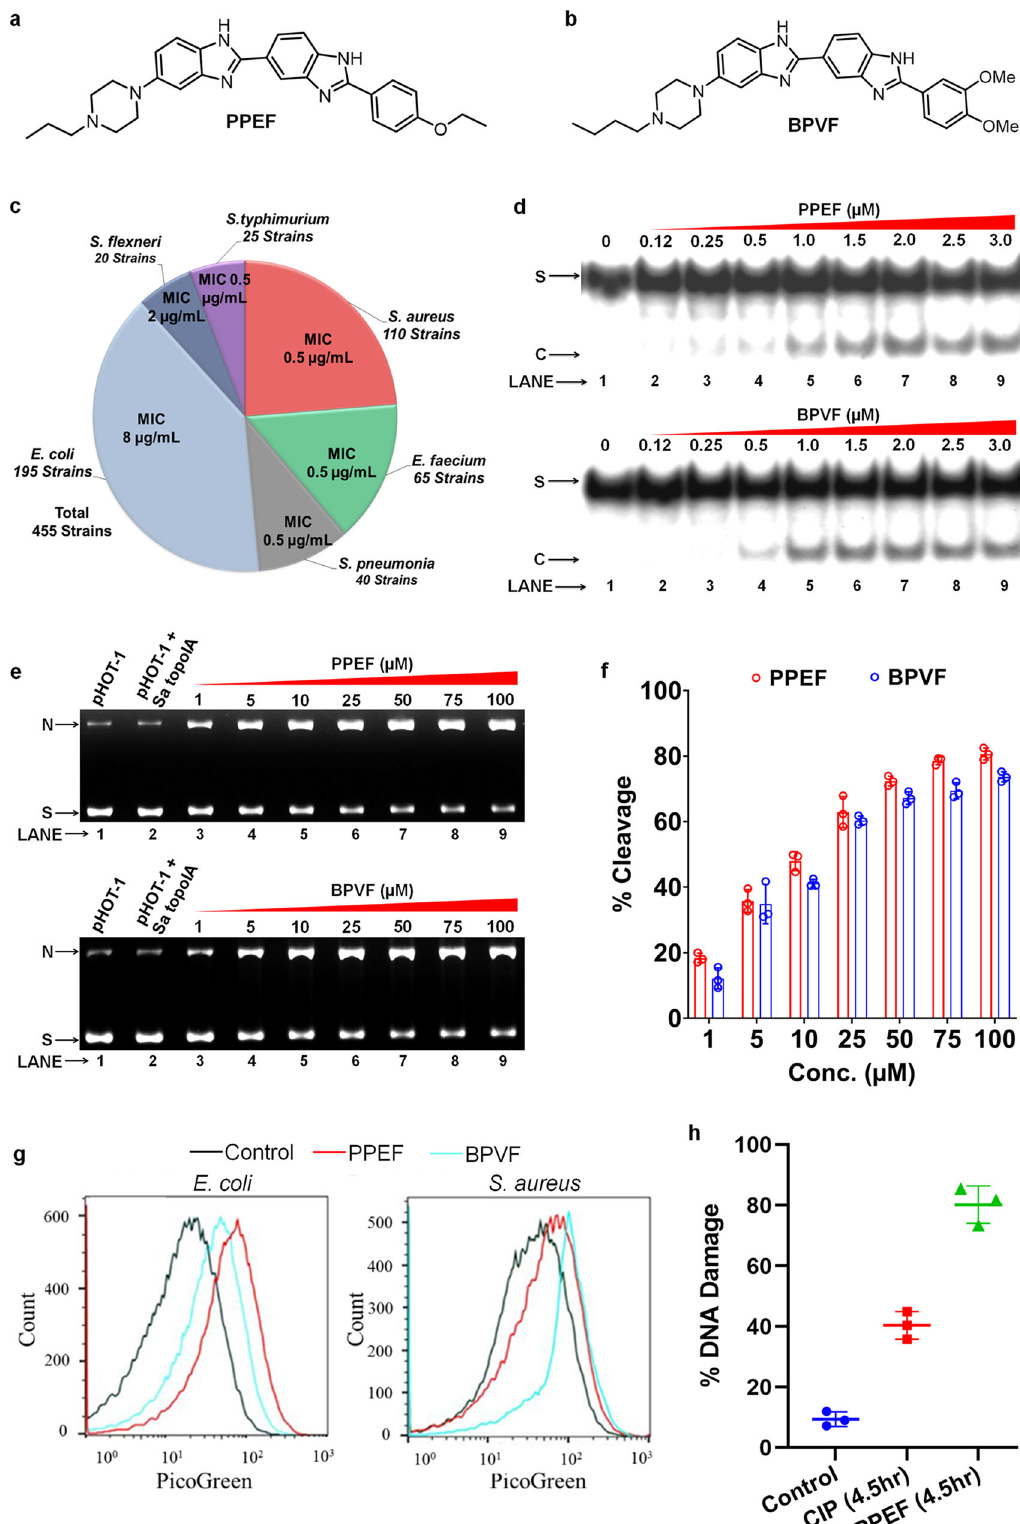
Flow cytometry-based Picogreen assay suggests PPEF and BPVF promote DNA fragmentation and condensation . DNA fragmentation and chromosomal condensation lead to physiolo- gical changes that induce cell cycle arrest and delayed repair pathways resulting in bacterial cell death 23 .